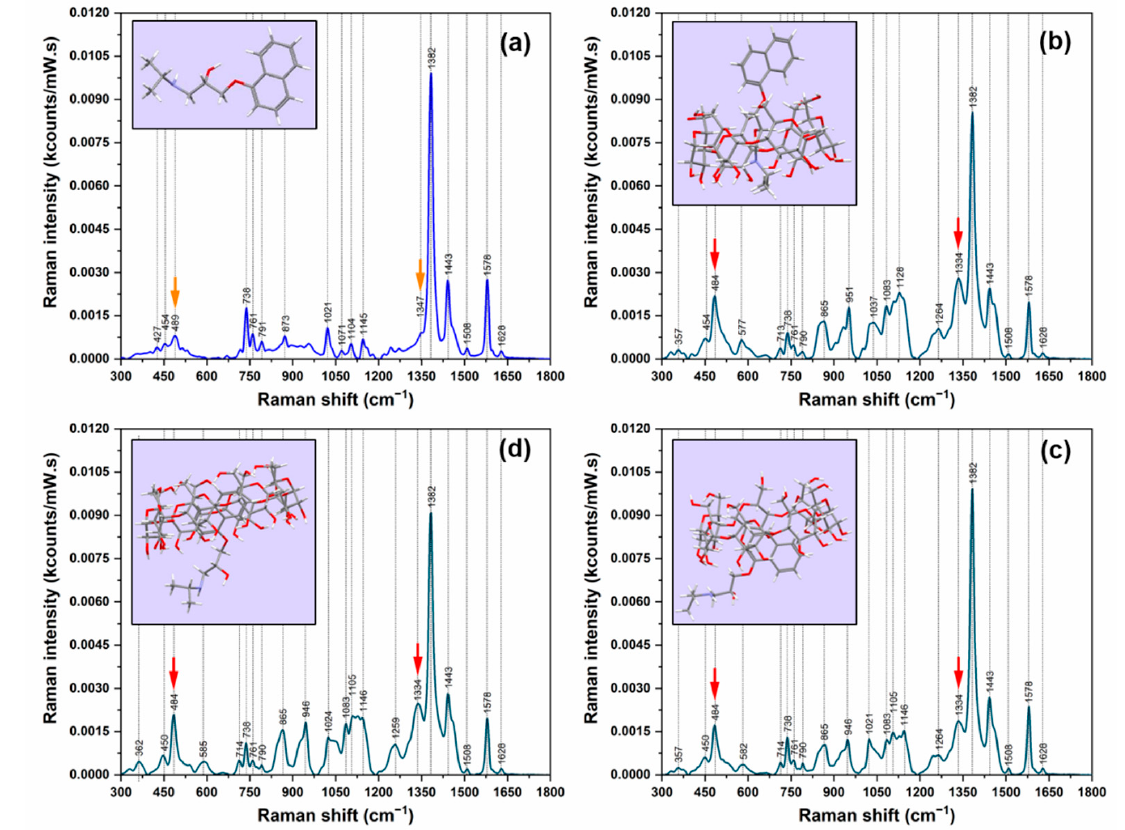
Figure 2. Raman spectra of R-PRNL ( a ) and of the complexes it forms with α CD ( b ), β CD, ( c ) and γ CD ( d ). The spectra were recorded by using an excitation laser of 785 nm. The arrows indicate the two bands specific for the complexes. The insets show the calculated geometries of inclusions.